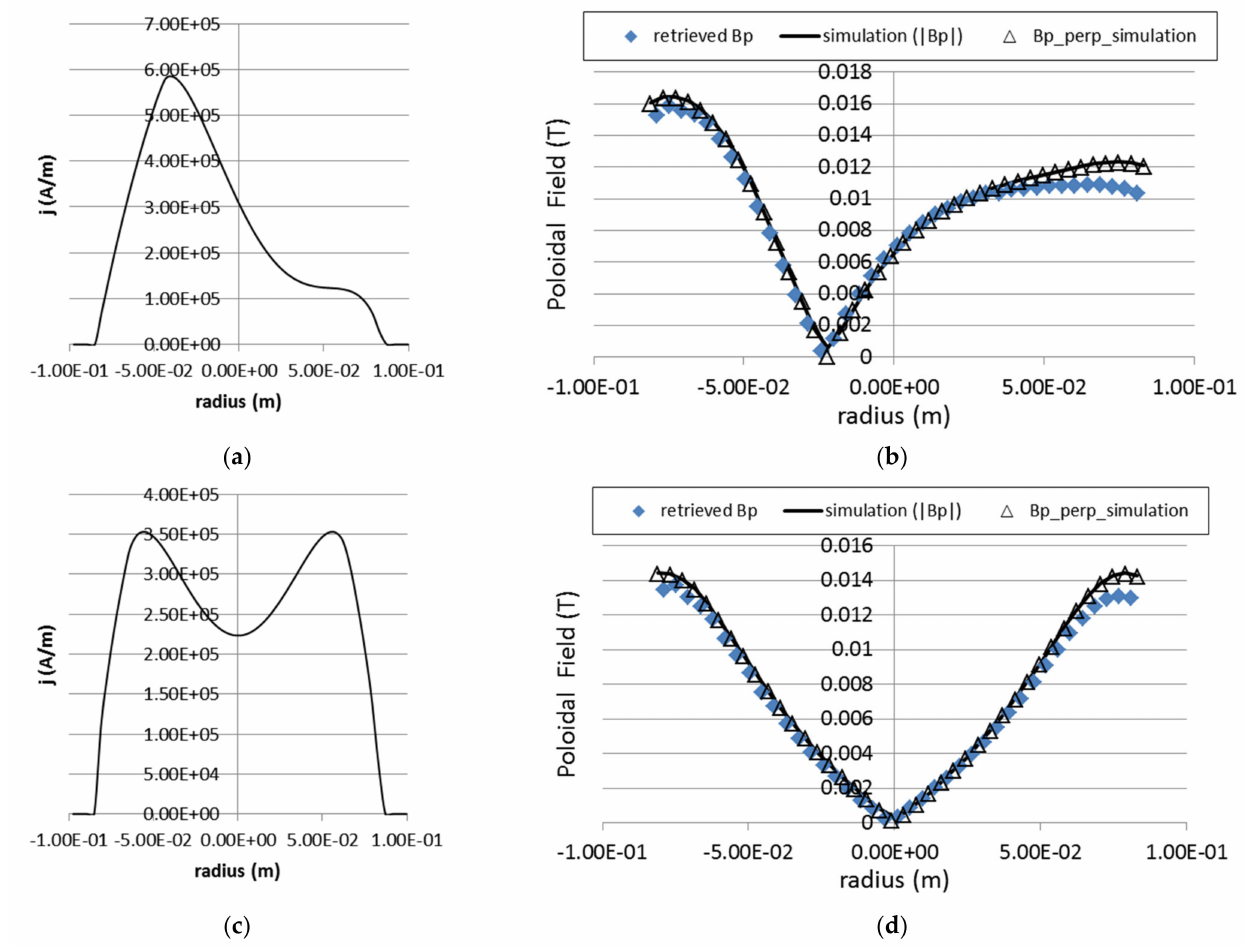
Figure 19. Retrieving of the poloidal field for an asymmetric and a hollow current density pro- files. On the left graphs ( a , c ) are represented the inputted current density profiles and on the right ( b , d ) the retrieved values of the corresponding poloidal magnetic fields based only on the position of the secondary ions on the